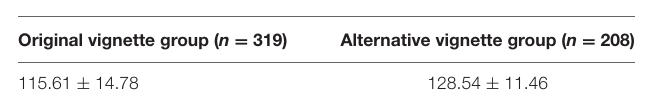
TABLE 7 | Correlation coefficients between ARS-30 and General Academic Self-Efficacy Scale (GASE). ARS-30